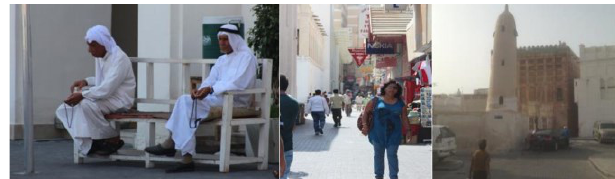
Figure 2. Inspiring the belongings in street furniture design from social and cultural elements (Researcher).